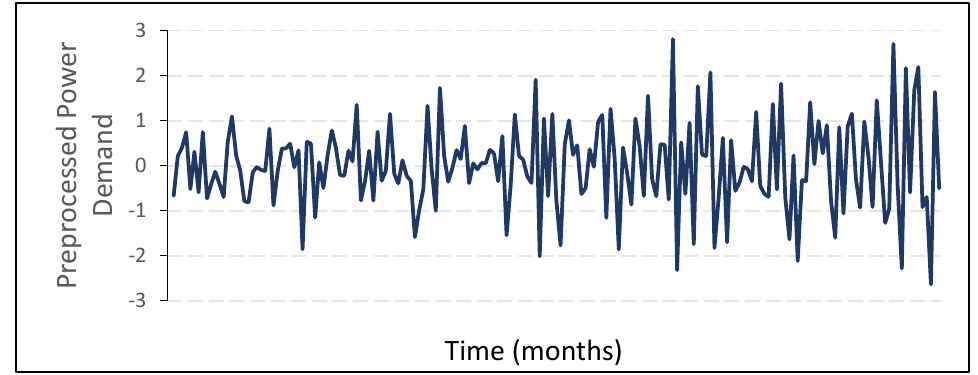
Figure 2. Paraná State energy consumption data for the period from January 2004 to June 2019, dif- Figure 2. Paran á State energy consumption data for the period from January 2004 to June 2019, ferentiated and seasonally adjusted. differentiated and seasonally